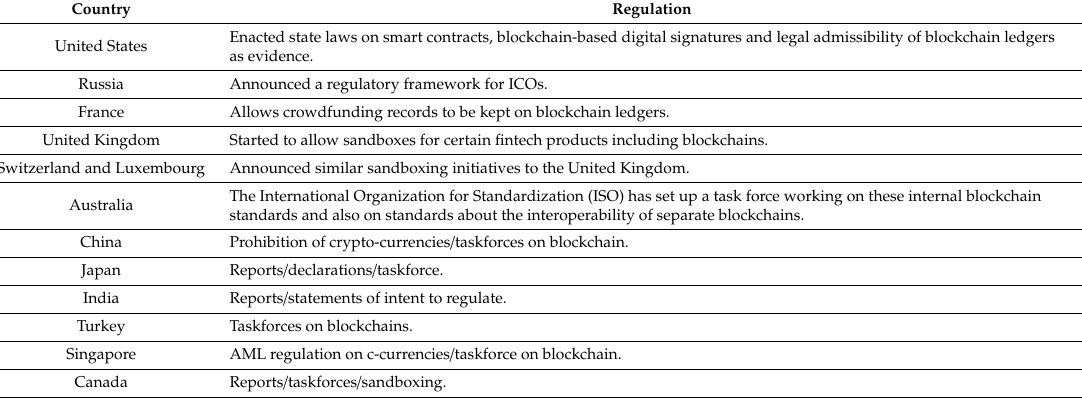
Table 8. Global Regulation of